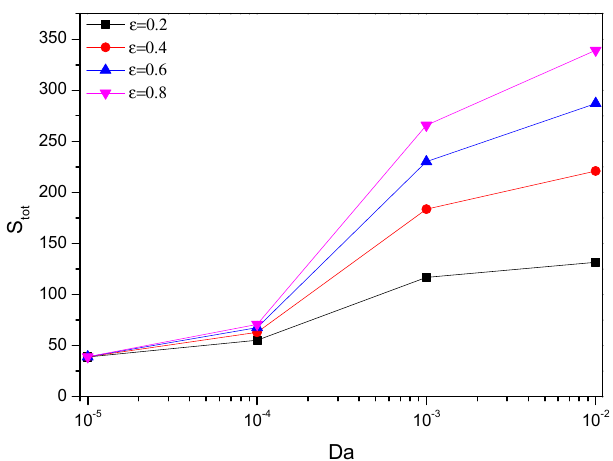
Figure 22. Average Nusselt number (Nuave) as a function of Darcy number (Da) at various values of ε. Ra =10 6 , 𝜙 = 0.02 and Ha = 0.